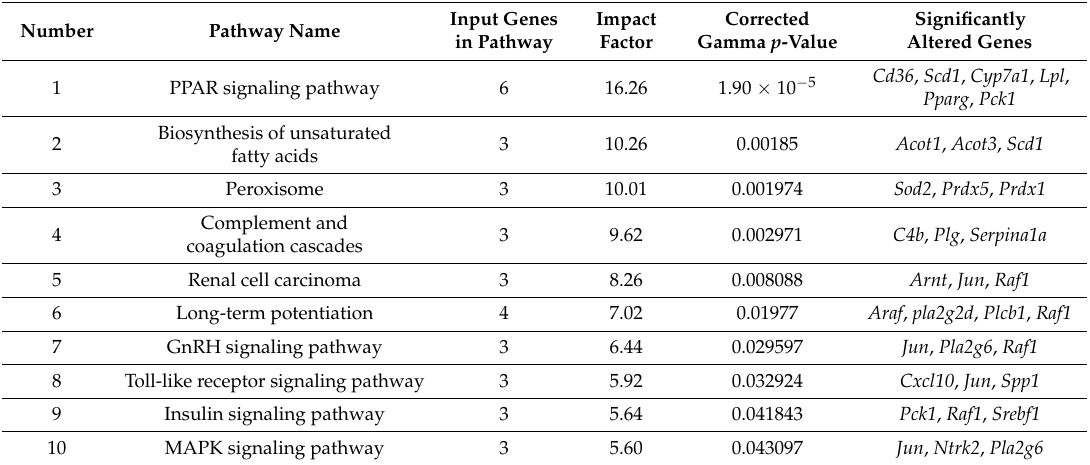
Table 2. Significantly altered biological pathways in livers of the HM mice compared to HFD mice.